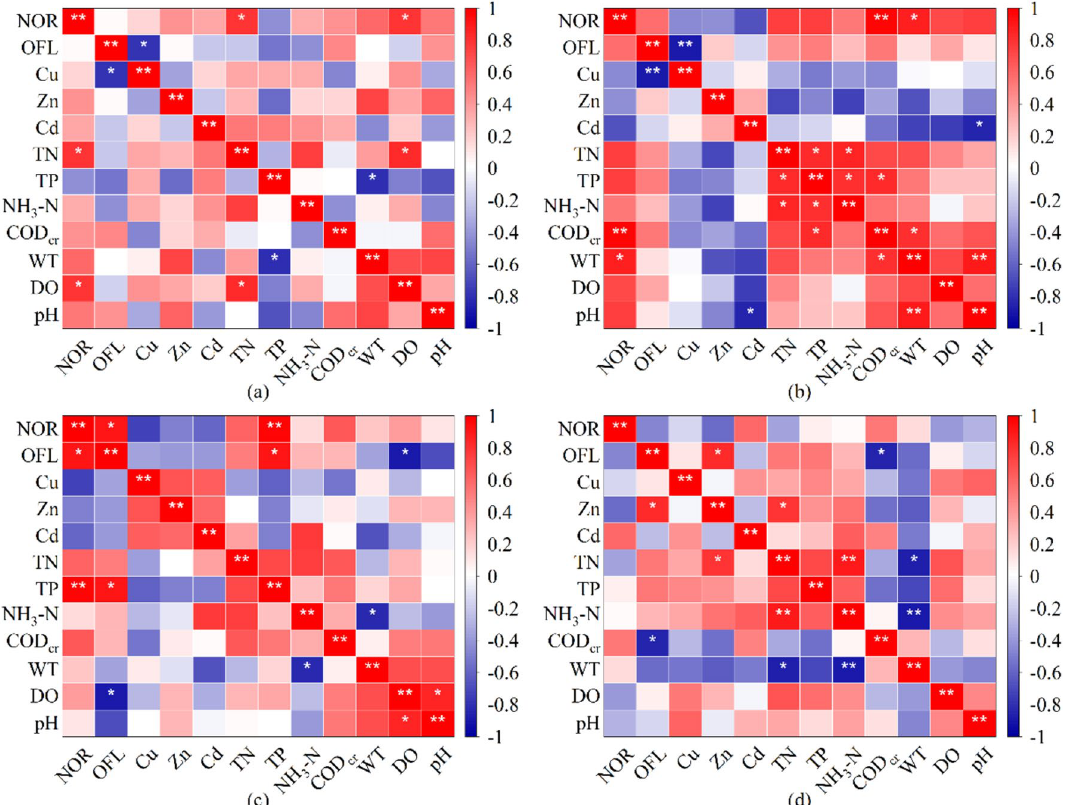
Figure 4. Correlation analysis of antibiotics, heavy metals and water quality conditions. ( a – d ) are heatmaps of correlation analysis for June, August, October and December, respectively. P < 0.05 for *, P < 0.01 for